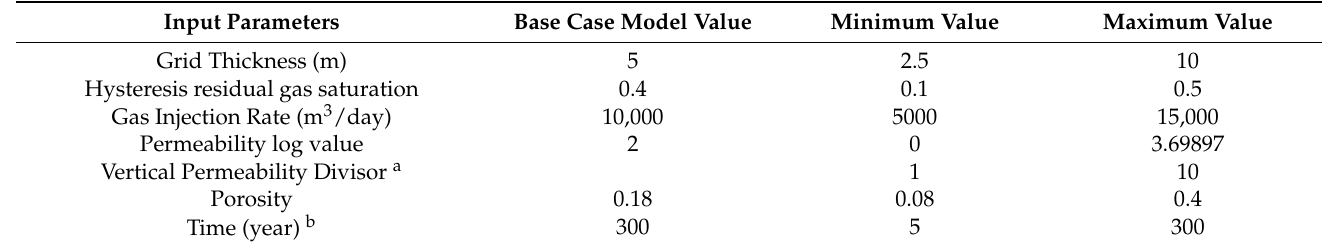
Table 3. Statistical overview of the input parameters distribution.